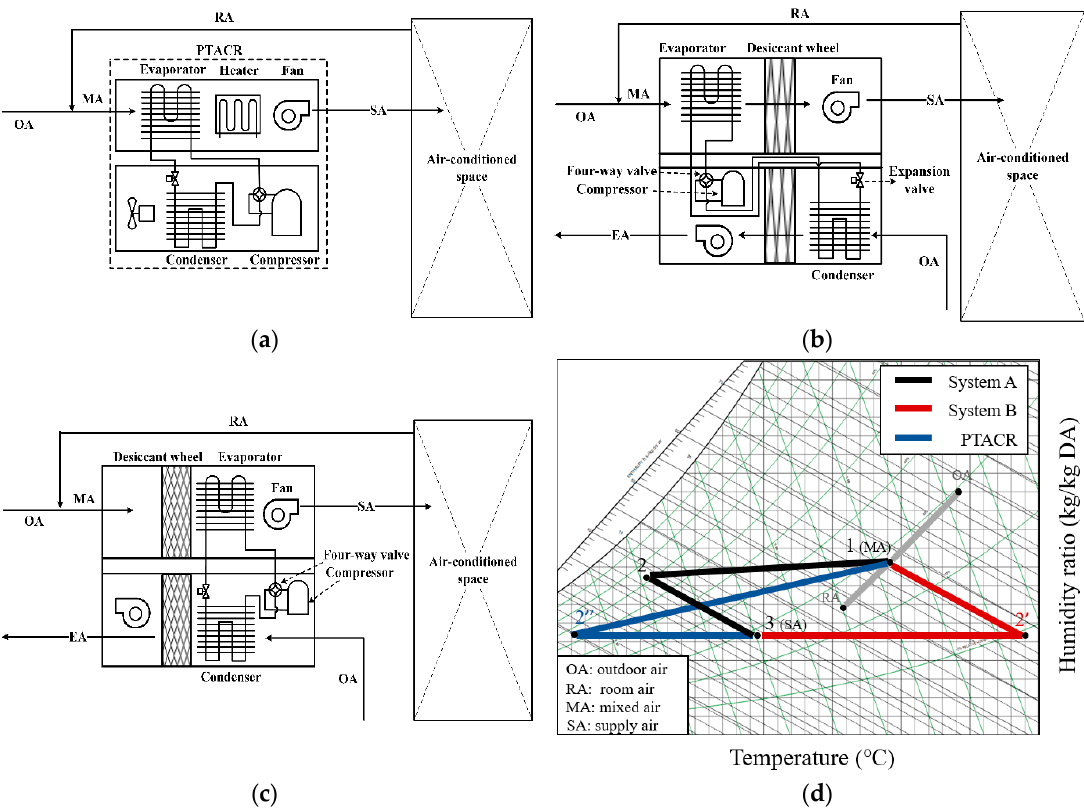
Figure 1. System configurations studied herein: ( a ) PTACR system ( b ) System A ( c ) System B ( d ) psychrometric chart.